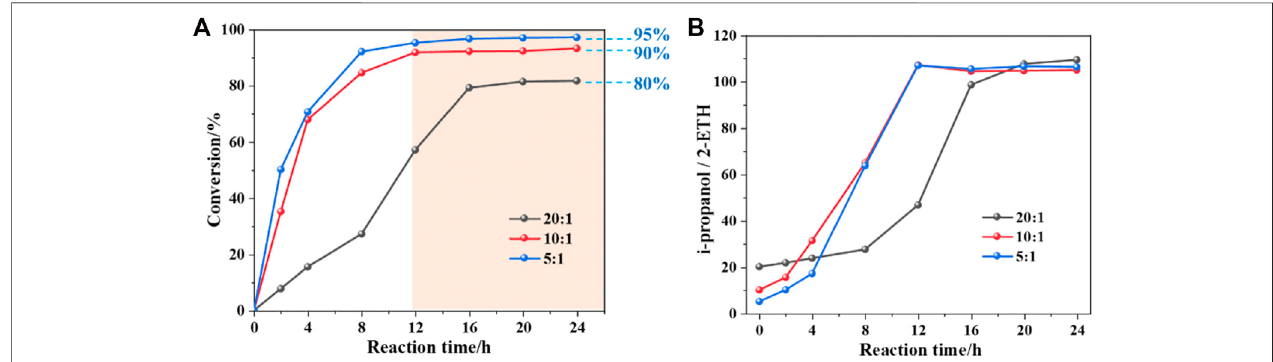
FIGURE1| Theprotectionphenomenonin i propanol: (A) theconversion of2-ETHasafunctionoftime and (B) the i propanol/2-ETH indifferent2-ETH massratios as a function of time.